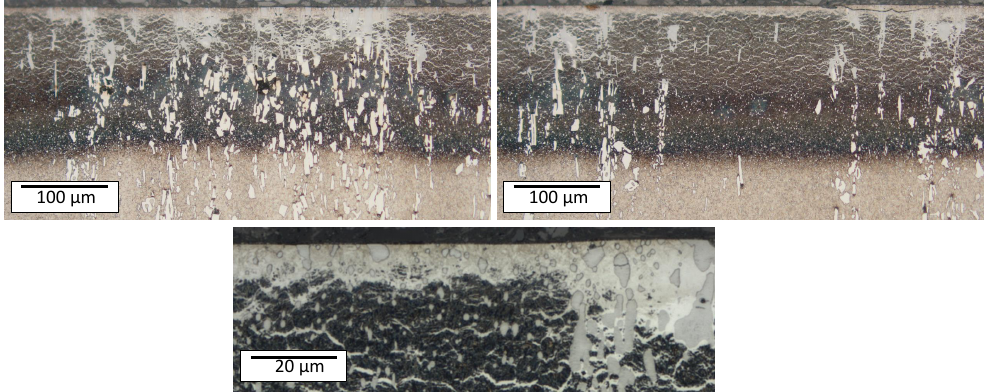
Figure 2. The heterogeneous pattern of the diffusion layer and the compound layer of the tool steel X153CrMoV12 illustrates the influence of the microstructure on the diffusion processes. In the carbide-rich area ( top-left image ), the diffusion zone appears to extend less in depth compared to the carbide-poor area ( top-right image ). The compound layer is also influenced by the carbides ( bottom image ).